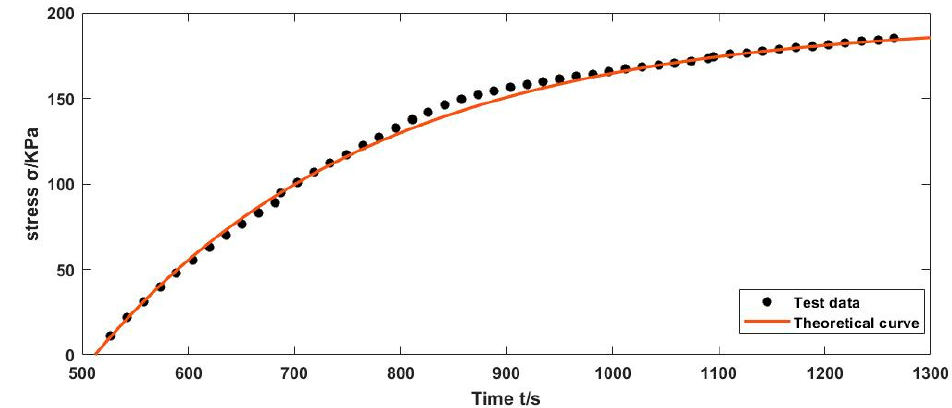
Figure 10. Comparison of the theoretical curve with our test data.